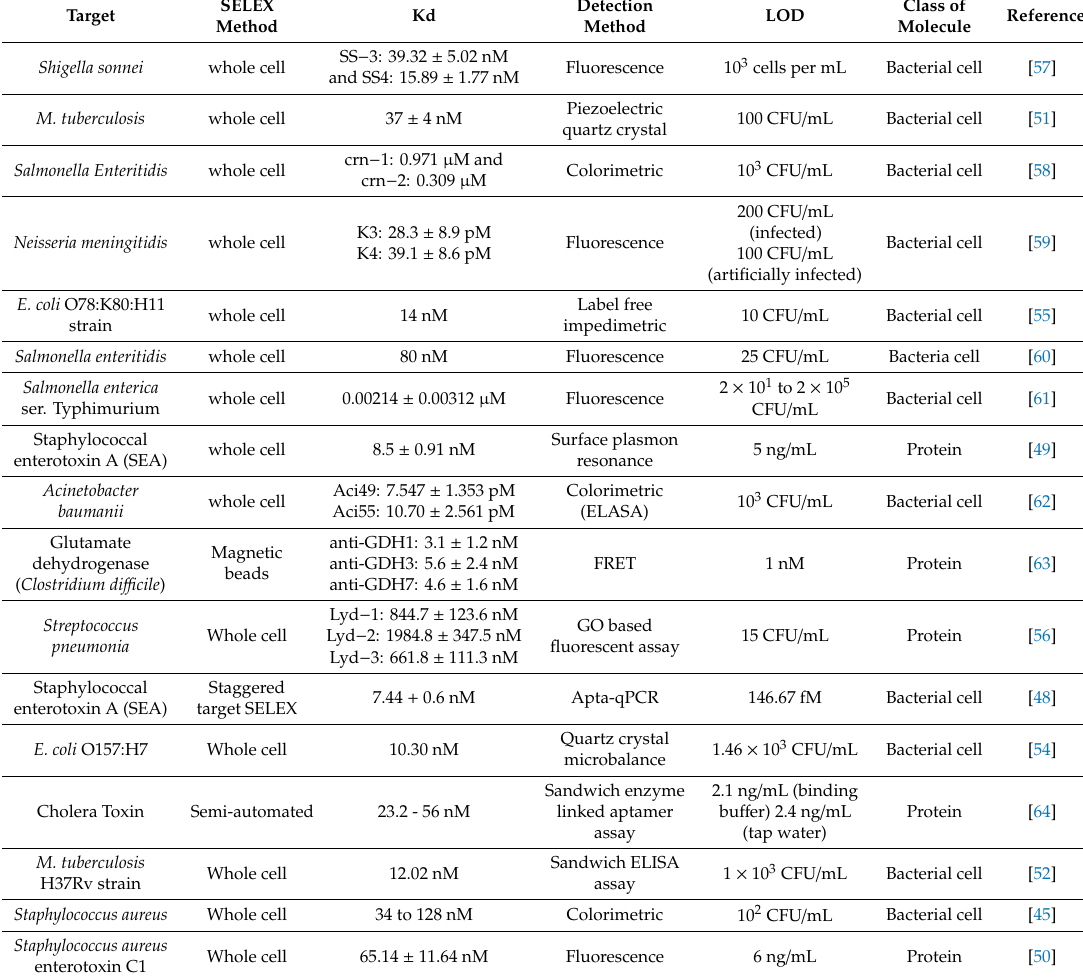
Table 2. Summary table of new ssDNA aptamers selected against bacteria and bacterial related targets and their diagnostic and biosensing applications.